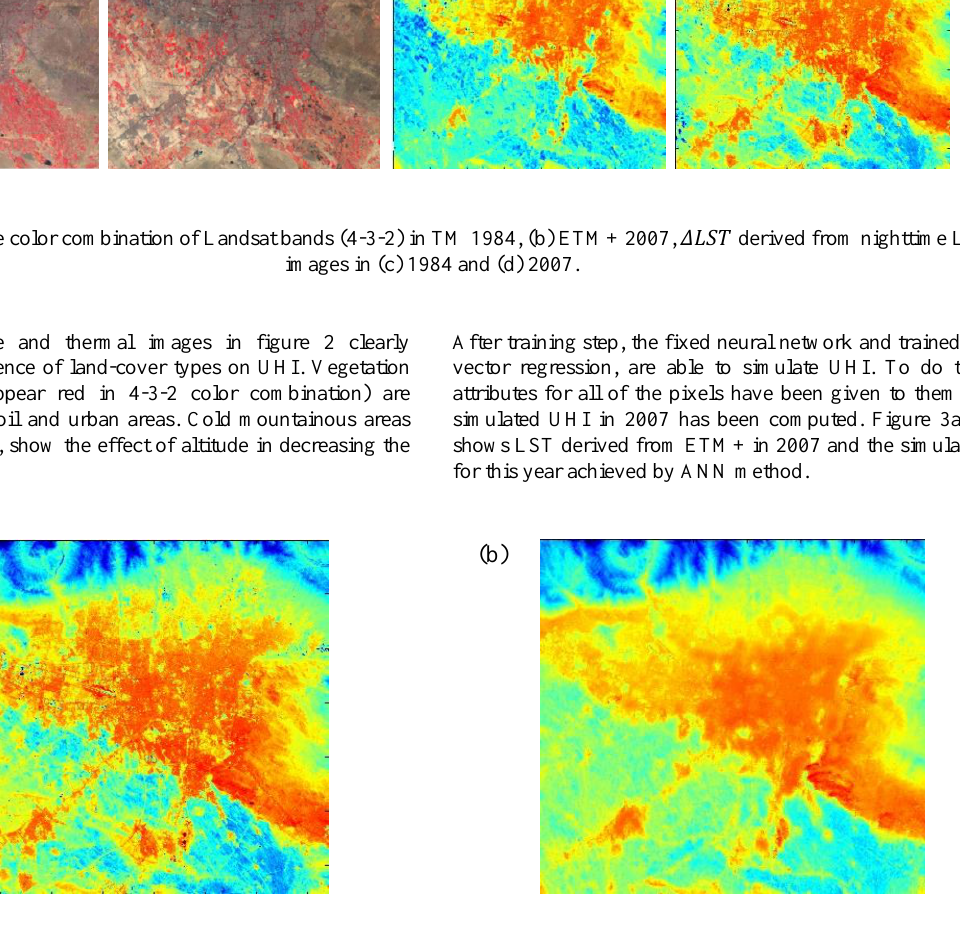
Figure 3. (a) in 2007 derived from ETM+ nighttime image, and (b) simulated computed from proposed model Table2 indicates the affection of number of training pixels on ANN but by increasing the number of training pixels, both result’s accuracy. It is concluded that with less number of methods have almost same correlation coefficients. training pixels, SVR can find the transfer rules much better than Table2, relationship of training data numbers and accuracy of the results Training data number (pixels)